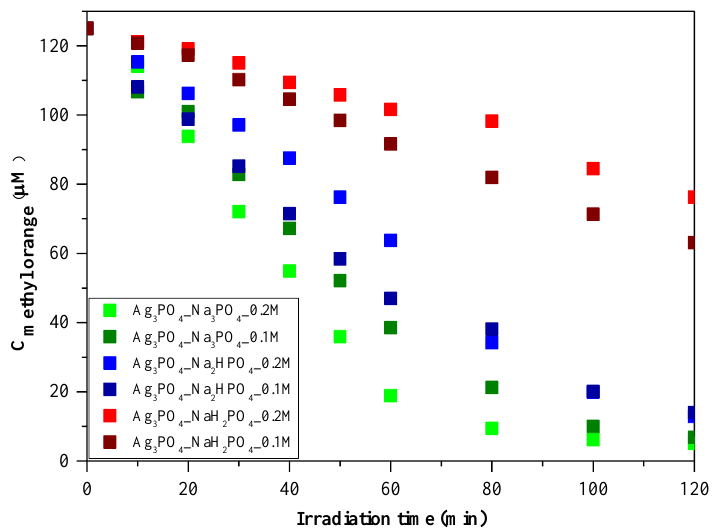
Figure 6. Photocatalytic investigation of Ag 3 PO 4 samples using C = 125 µ M of MO as a model pollutant and visible light ( λ > 400 nm) as a light source.